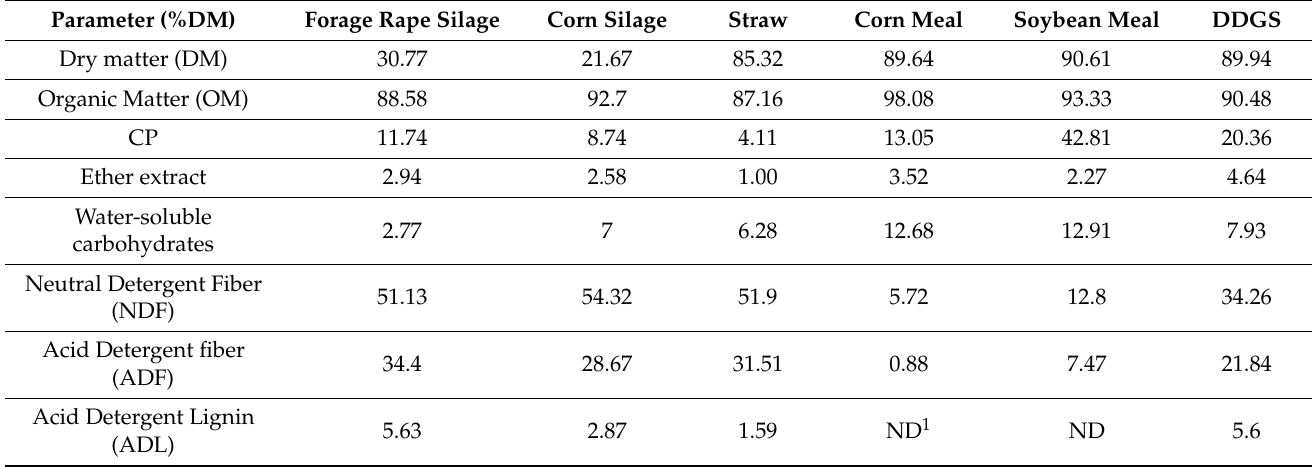
Table 1. Chemical composition of feed ingredients.